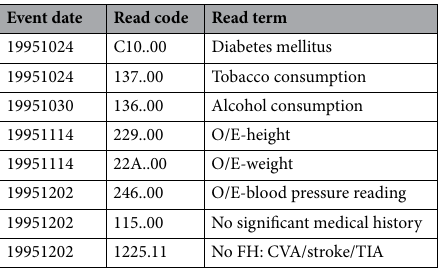
Table 1. A sample of symbolic representation a patient data. The Read codes are extracted as a sequence of symbols and ordered according to the event